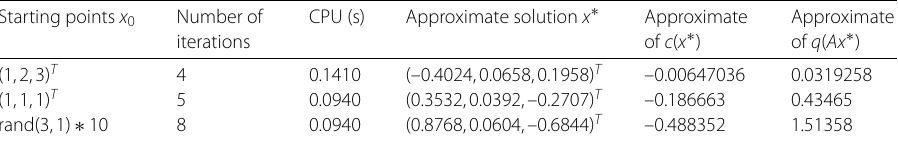
Table 4 Results for Example 5.4 using Li method in Algorithm 1 [8]